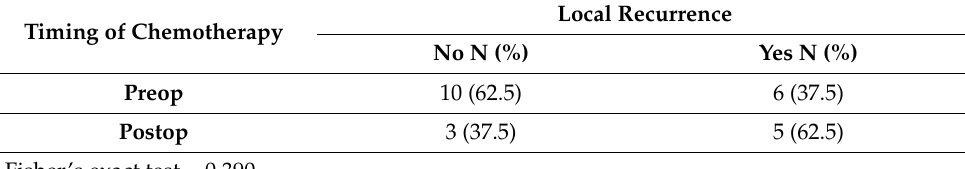
Fisher’s exact test = 0.390 Timing of Chemotherapy